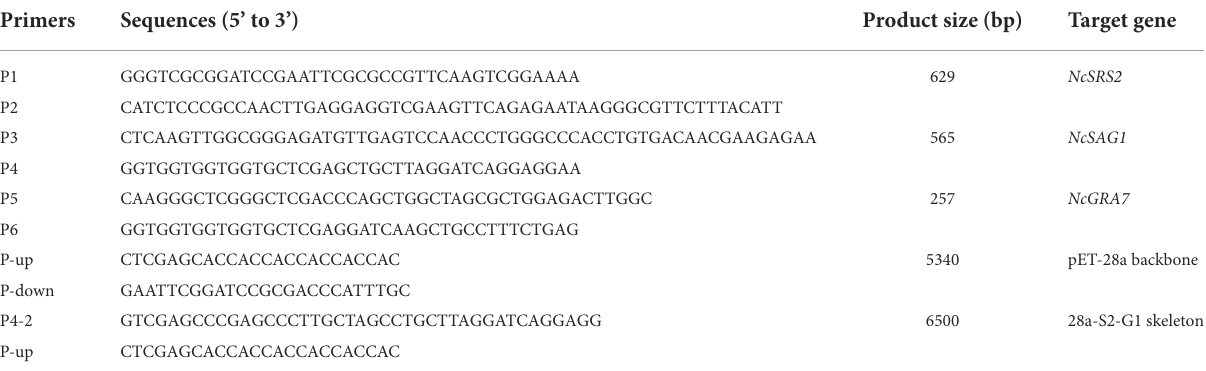
TABLE 1 Primers for amplifying the NcSRS2, NcSAG1, NcGRA7, pET-28a plasmid backbone and 28a-S2-G1 carrier skeleton, and product sizes.